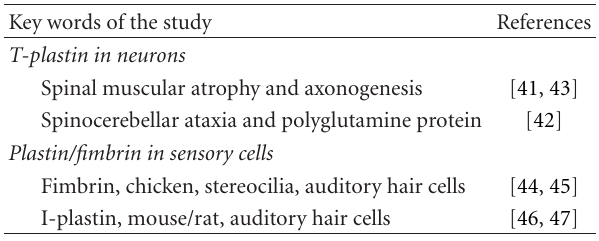
Table 3: Studies on plastins in the nervous system and sensory cells.